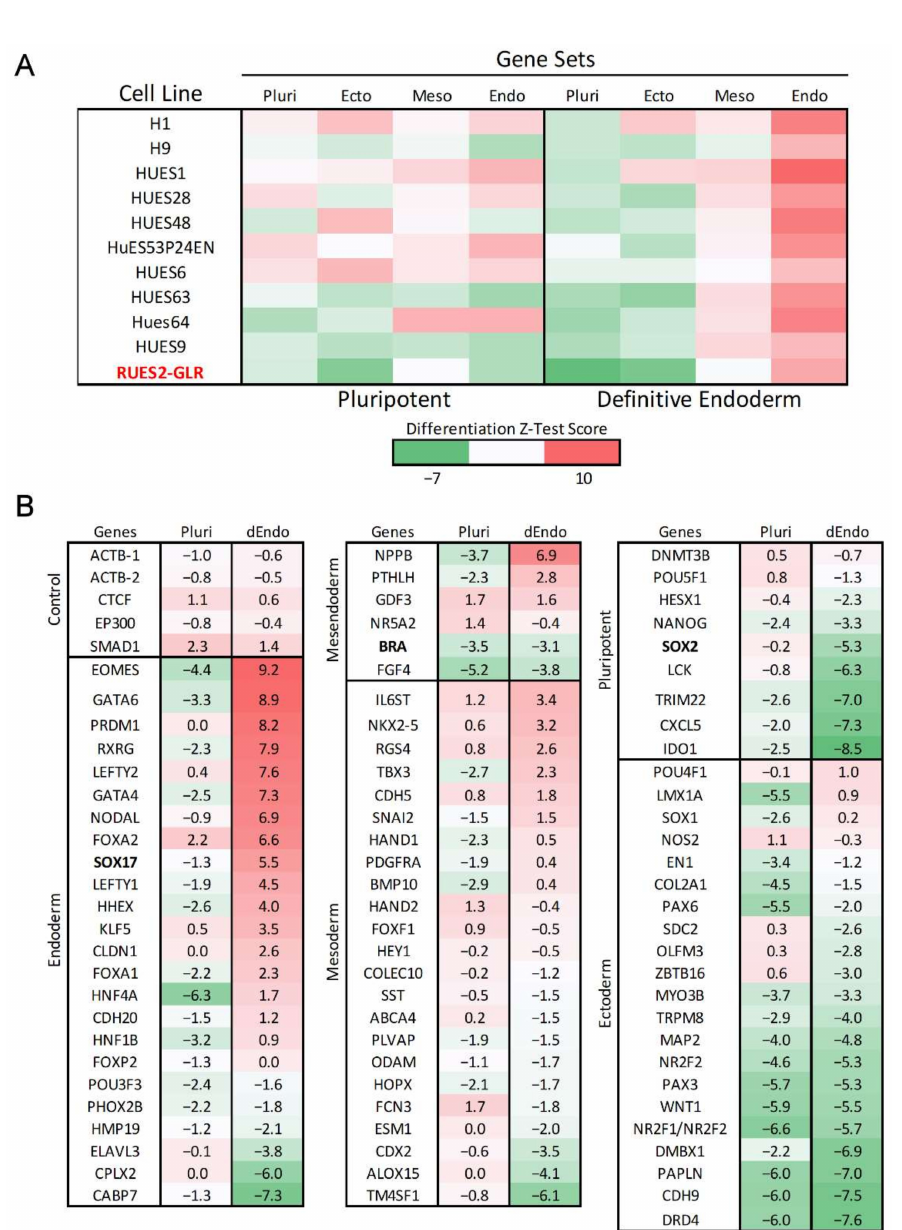
Figure 1. Gene expression of RUES2-GLR directed endoderm differentiation. Gene expression of RUES2-GLR at 48 h (Red) in pluripotent and directed endoderm states using the hPSC Taqman Scorecard array. ( A ) Heatmap of Z-test scores calculated from aggregate hPSC Scorecard gene data for multiple human pluripotent stem cell lines in pluripotent and directed endoderm conditions classified by differentiation state. All scores were compiled from published data [54] except RUES2-GLR which was generated for comparison to other cell lines. Pluripotent (Pluri), Ectoderm (Ecto), Mesoderm (Meso), Endoderm (Endo). ( B ) hPSC Scorecard log2 fold gene expression changes compared to published data of ten pluripotent stem cell lines for genes of each differentiation state ( n = 3). Colorimetric scale indicates high (red), neutral (white), and low (green) gene expression. Directed Endoderm